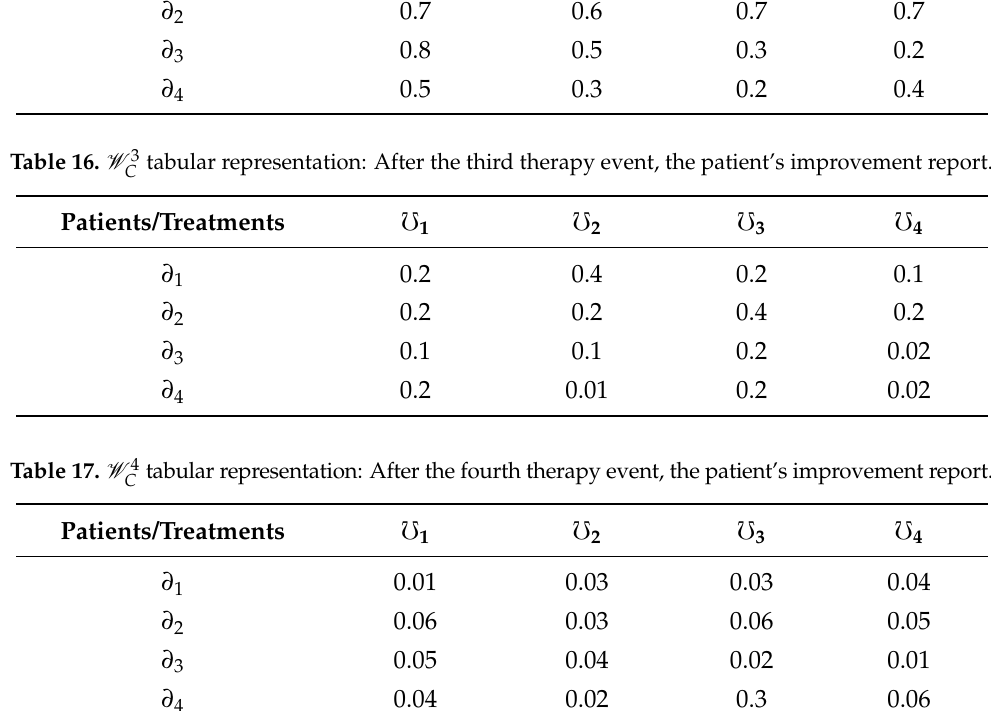
tabular representation: After the fifth therapy event, the patient’s improvement report. C